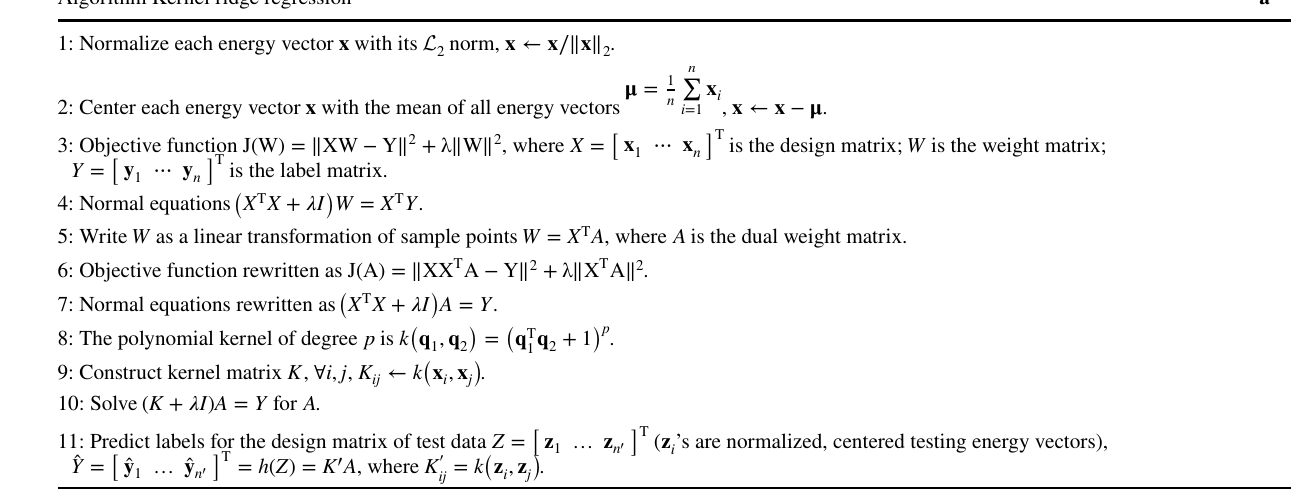
Table 1 Machine learning algorithm details Algorithm Kernel ridge